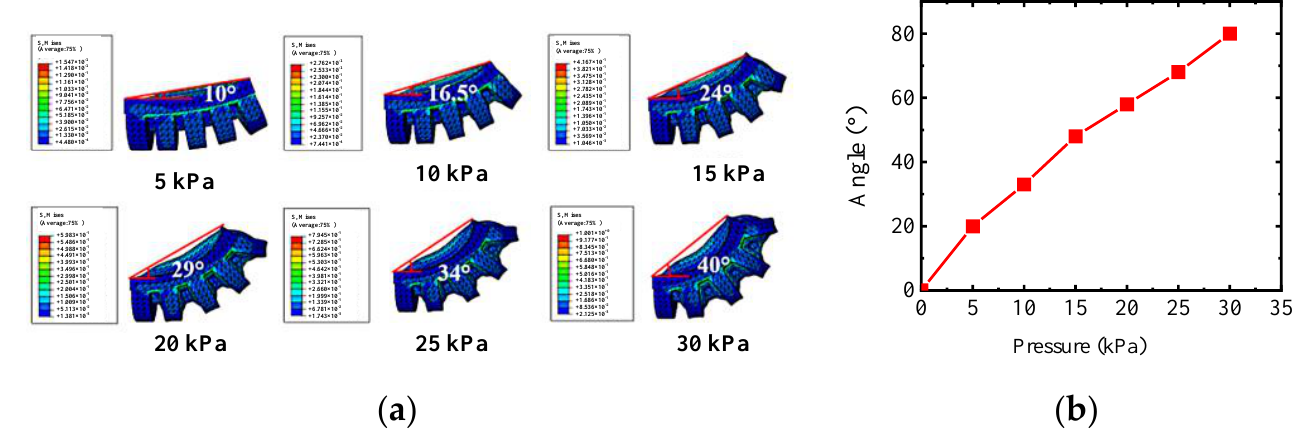
Figure 11. Simulation results of rotating actuator for thumb. ( a ) Simulation results of thumb actuator and ( b ) simulation curve of thumb.